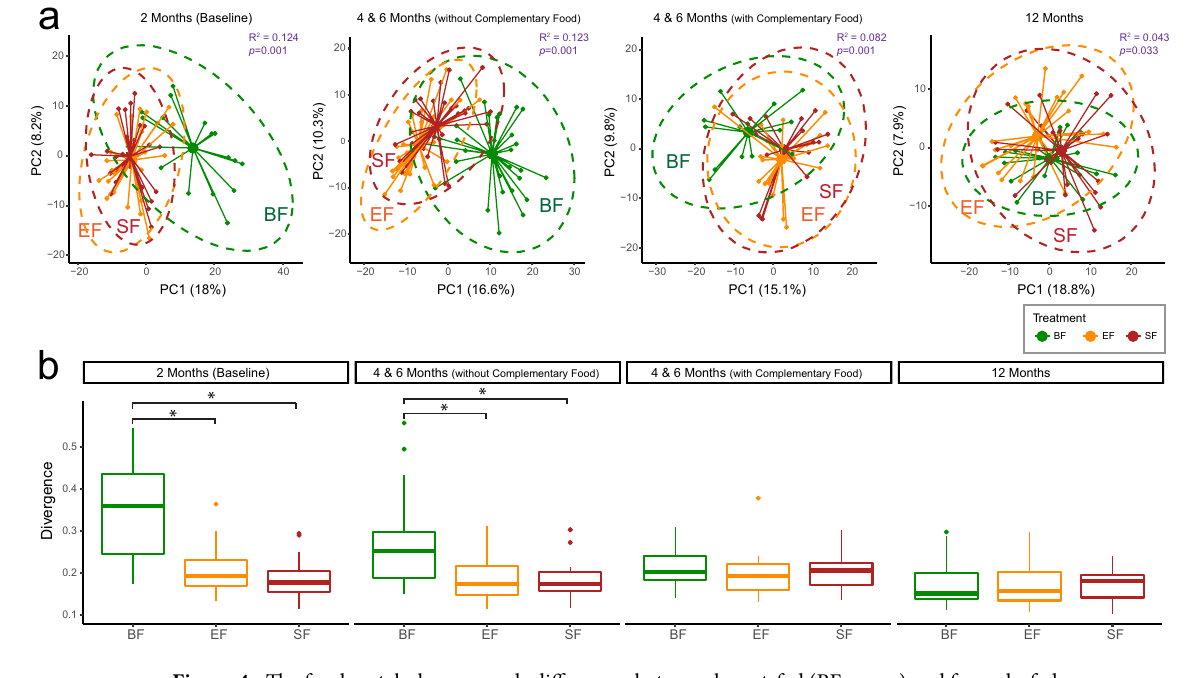
Figure 4. The fecal metabolome reveals differences between breast-fed (BF, green) and formula-fed (Experimental Formula, EF, orange; Standard Formula, SF, red) infants at 2, and 4 & 6 months of age. ( a ) Principal Coordinates Analysis (PCoA) of the Euclidean distance matrix of the generalized log transformed fecal metabolite concentration data. The centroids of each cluster (centroid of mass) were calculated as the average PC1 and PC2 of all samples for each group. The ellipses were constructed based on multivariate normal distribution at 95% confidence level. The effect size (R 2 ) and significance (p-value) between dietary groups were evaluated using permutational MANOVA via the Adonis test (permutation = 999). ( b) Divergence (the spread within each group) is significantly higher in BF infants during the exclusive feeding period. The measurement of divergence was calculated as 1- the average spearman correlation between samples and the overall group-wise average. The group difference was evaluated using Kruskal-Wallis H test follow by post-hoc Dunn test, p <